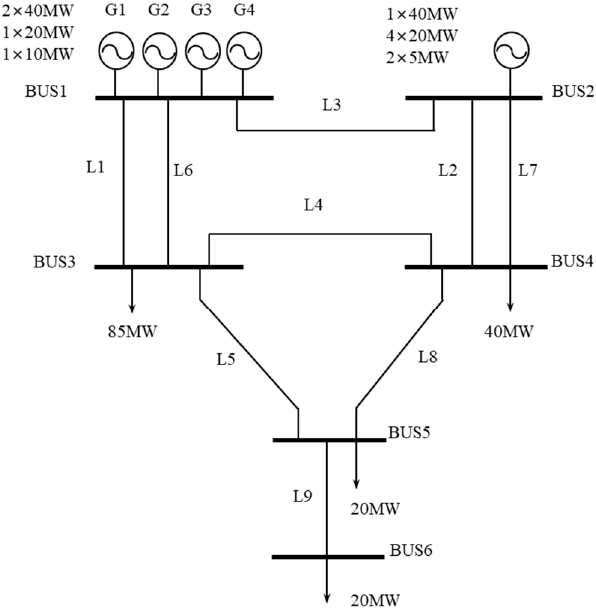
Figure 3. The single-line diagram of RBTS.